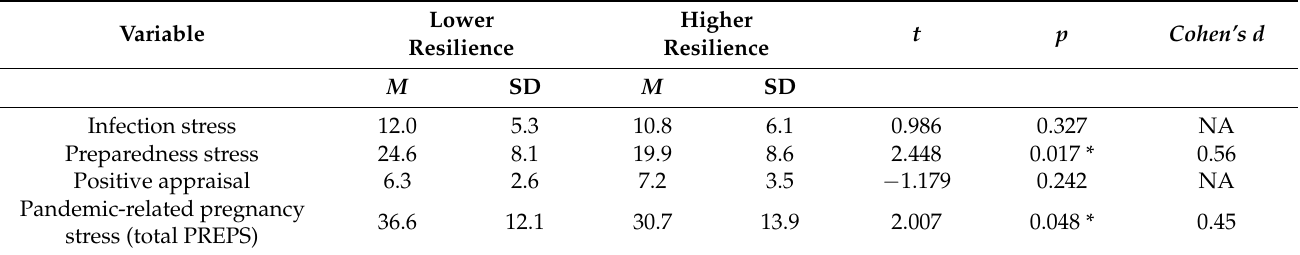
Table 3. Comparison of the prenatal stress related to the COVID-19 pandemic measured by PREPS in groups with low and high levels of resilience.